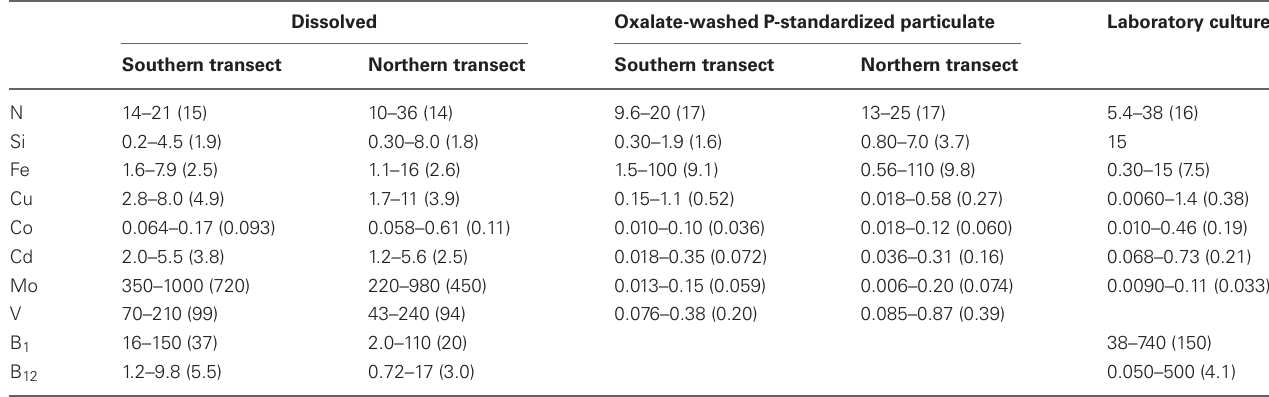
Table 1 | Comparison of the range and median values (in parentheses) of dissolved and oxalate-washed, particulate nutrients with literature values from laboratory culture experiments, standardized to P.